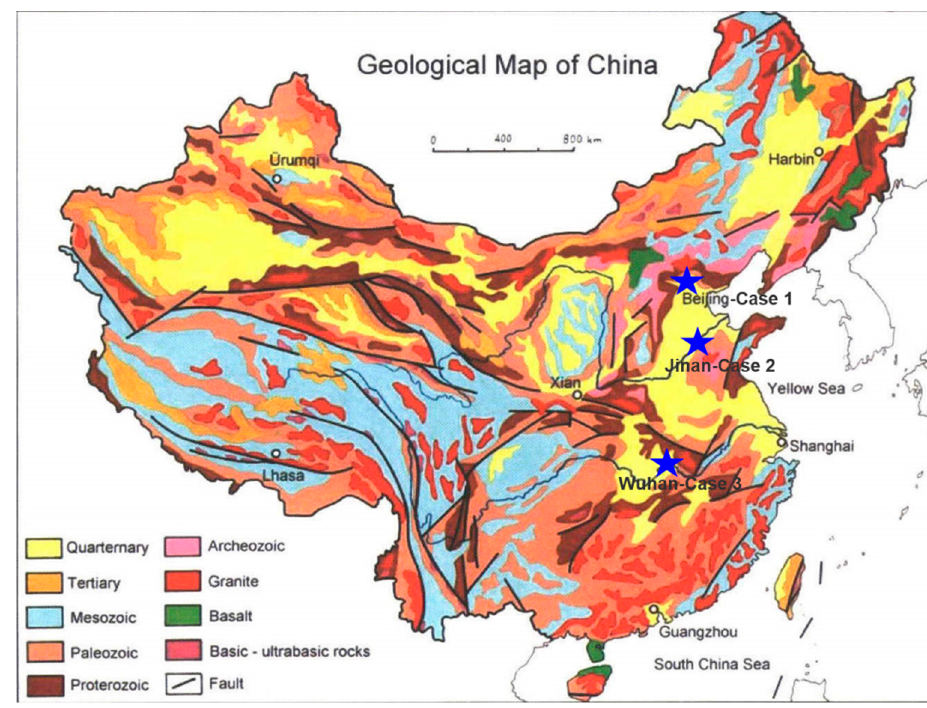
Figure 1. Geological overview map where the location of the three